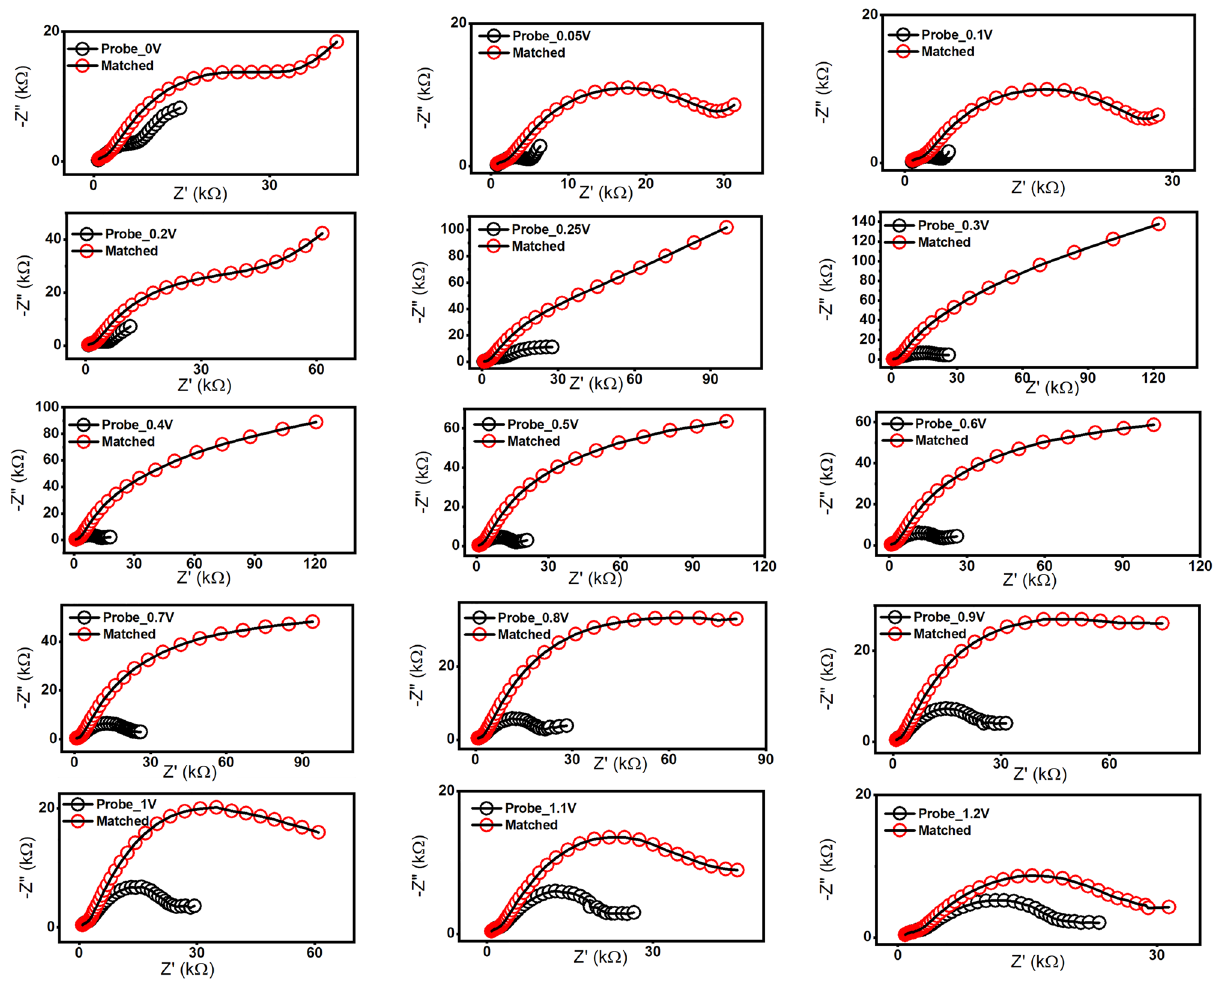
Figure 4. Effect of applied DC on the fabricated biosensor chips. Remarkable signals were obtained at 0.3 V. The study was applied before and after the hybridization with 10 µM of the matched